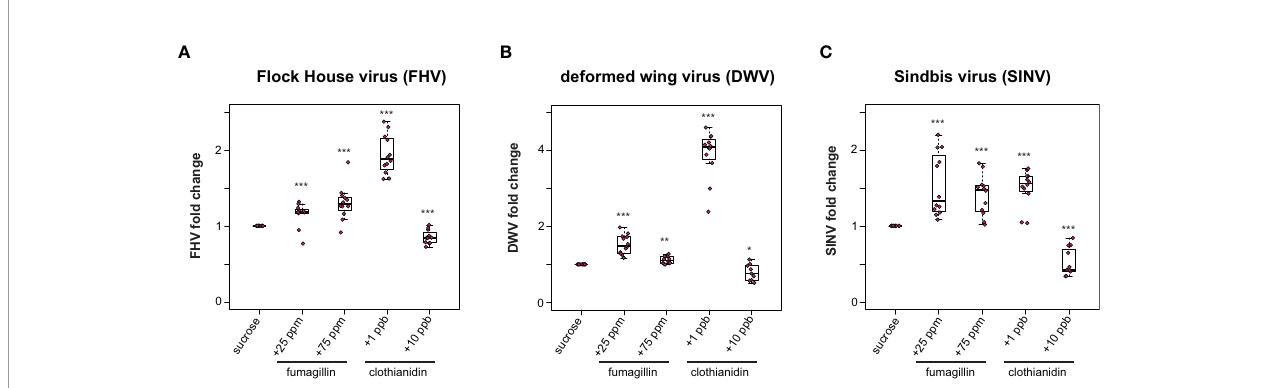
FIGURE 2 | Honey bees fed sucrose syrup containing fumagillin or clothianidin had greater virus levels than bees feed only sucrose syrup. Virus abundance in individual honey bees that were either fed sucrose syrup only or fungicide or insecticide containing sucrose syrup was assessed at 72 h post-infection by qPCR (n = 9-12 per treatment group) and the relative virus abundance is presented as ranked fold-changes. Data from virus infected honey bees fed sucrose syrup mixed with fumagillin (25 ppm or 75 ppm) or clothianidin (1 ppb or 10 ppb) illustrate that bees fed sucrose syrup containing 25 ppm fumagillin, 75 ppm fumagillin, and 1 ppb clothianidin harbored more virus than virus-infected bees fed sucrose syrup only, whereas bees fed sucrose syrup containing 10 ppb clothianidin had lower virus levels (A) Flock House virus (FHV)-infected bees fed 25 ppm fumagillin ( p = 0.006), 75 ppm fumagillin ( p = 0.0009) or 1 ppb clothianidin ( p = 8.2 x 10 -5 ) containing sucrose syrup had greater virus levels than bees fed sucrose only syrup. Whereas, FHV-infected bees fed sucrose syrup containing 10 ppb clothianidin had lower virus levels than bees fed only sucrose syrup ( p = 0.0009). (B) Deformed wing virus (DWV)-infected bees fed sucrose syrup containing 25 ppm fumagillin ( p = 8.2 x 10 -5 ), 75 ppm fumagillin ( p = 0.0022) or 1 ppb clothianidin ( p = 8.2 x 10 -5 ) harbored more virus than DWV-infected bees fed only sucrose syrup. DWV-infected bees fed 10 ppb clothianidin containing sucrose syrup had less virus compared to bees fed sucrose syrup ( p = 0.04). (C) Sindbis virus (SINV) abundance was higher in bees fed sucrose syrup containing 25 ppm fumagillin ( p = 6.2 x 10 -5 ), 75 ppm fumagillin ( p = 6.2 x 10 -5 ) or 1 ppb clothianidin ( p = 6.2 x 10 -5 ) compared to SINV-infected bees fed only sucrose syrup. In contrast, SINV-infected bees fed sucrose syrup containing 10 ppb clothianidin had lower levels of virus infection than bees fed sucrose only syrup ( p = 6.8 x 10 -5 ). Data were analyzed by a pairwise Wilcoxon Rank Sums with a Benjamini – Hochberg correction for multiple comparisons. Asterisks indicate a signi fi cant change in virus abundance; signi fi cance levels: * p < 0.05; ** p < 0.005; *** p < 0.0005. This fi gure includes results from one representative biological replicate for each virus (i.e., rep3). The data for all three biological replicates are presented in Supplemental Figure S3 . Raw data are included in Supplemental Tables S5 , S6